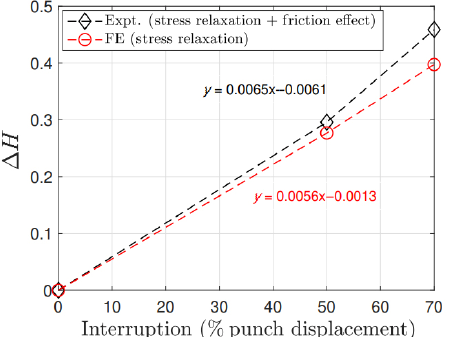
Fig. 17 Comparison of friction and stress relaxation effect in interrupted HET (the functions represent the trendline of the data points).